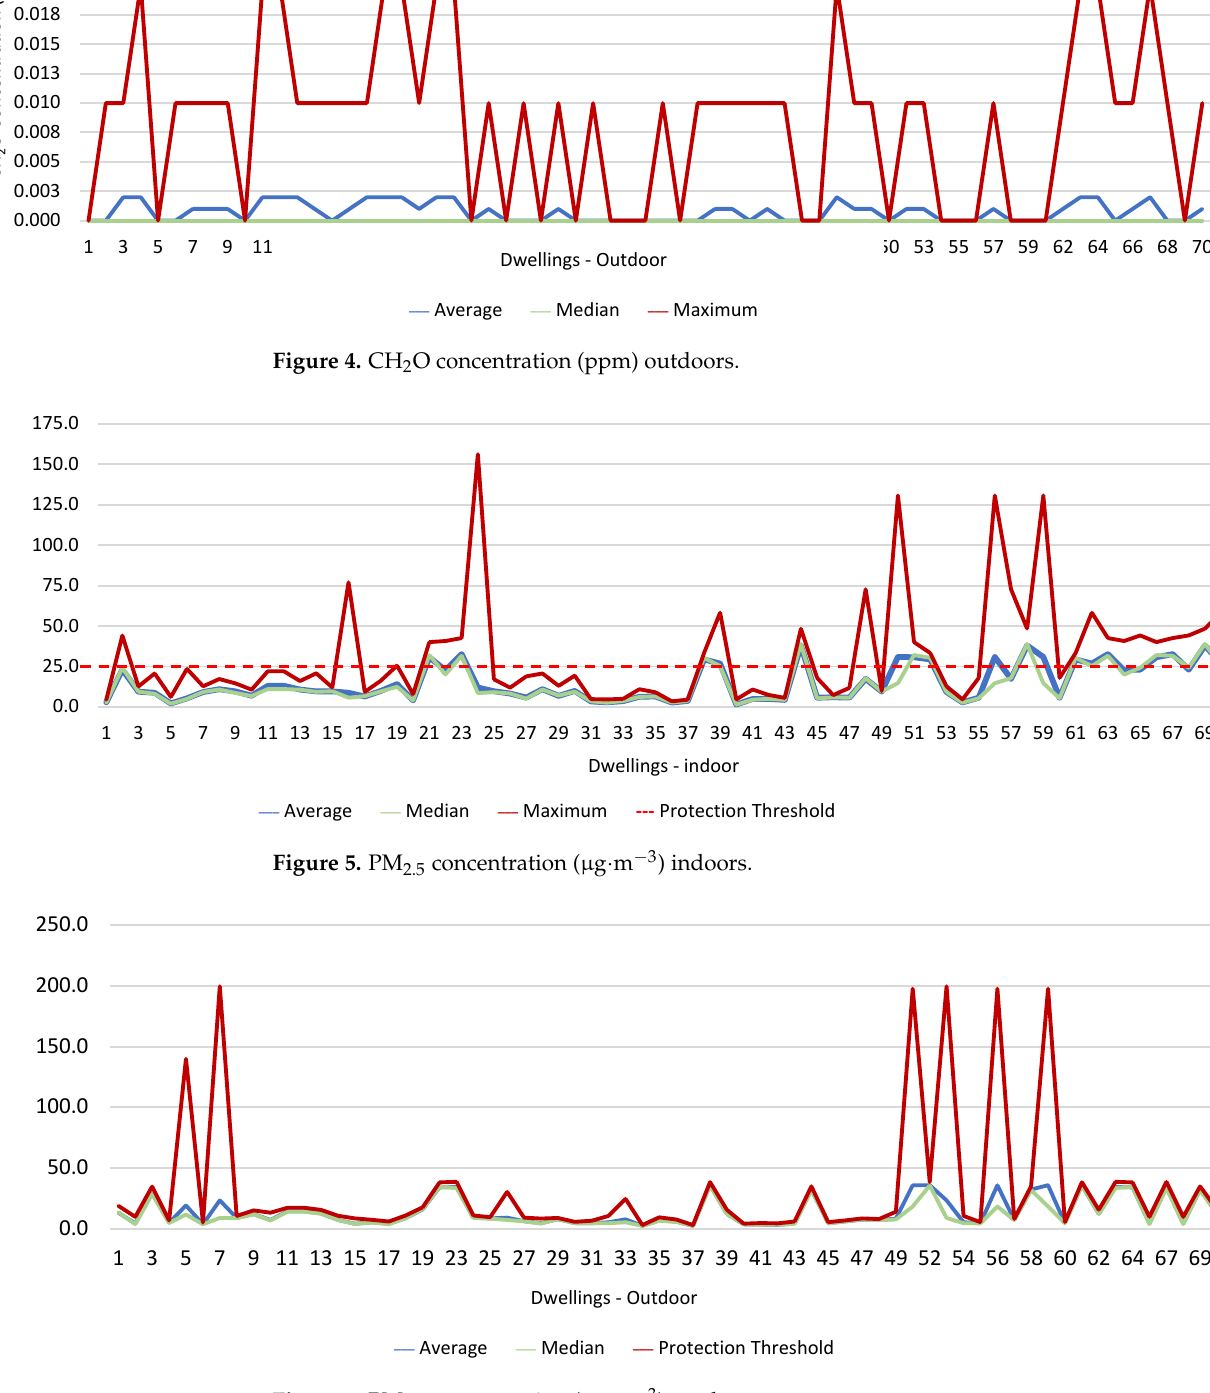
Figure 6. PM 2.5 concentration ( μ g·m − 3 ) outdoors.